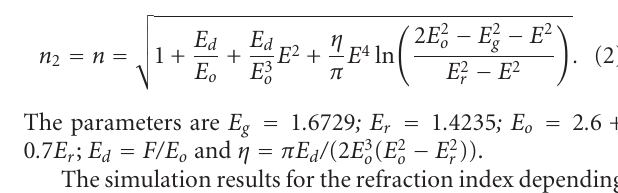
configuration in order to obtain maximum output electrical power, for a certain state of illumination